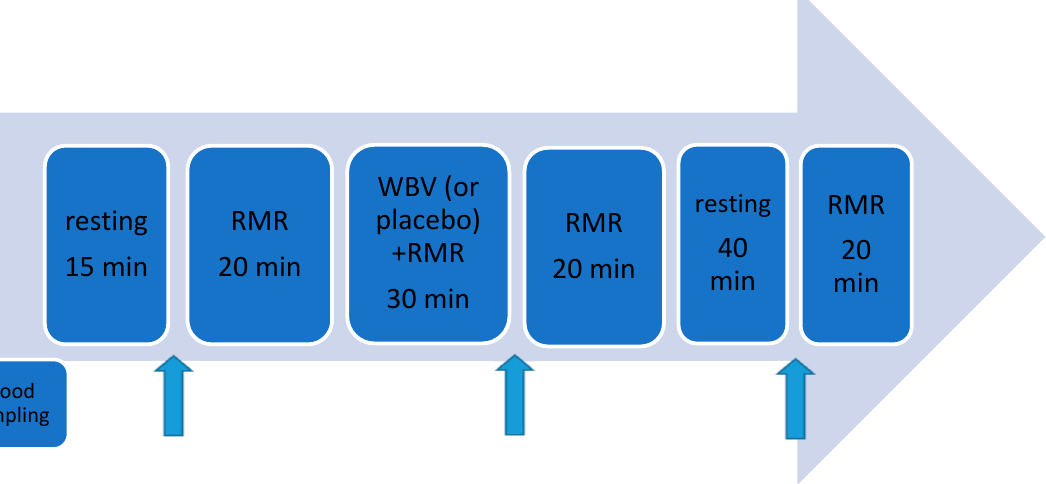
Figure 1. Measurement diagram for whole-body vibration and placebo condition (random order of groups). RMR—resting metabolic rate, WBV—whole-body vibration.